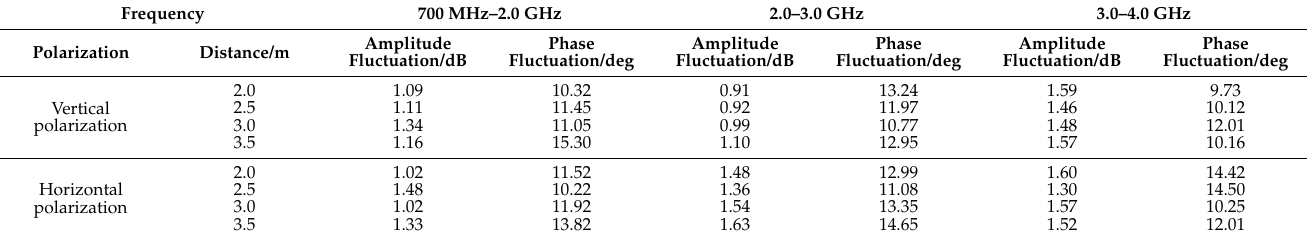
Table 2. Verification results of plane wave performance test.